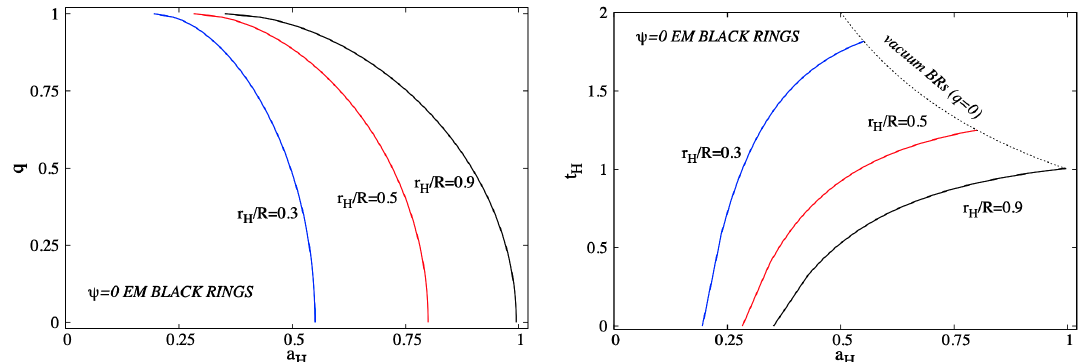
Figure 8 . Same as figure 7 for charged